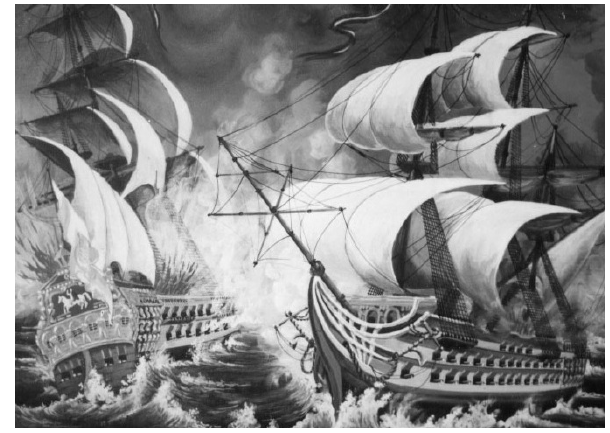
Figure 3. The image we used to train the ferns based descriptor